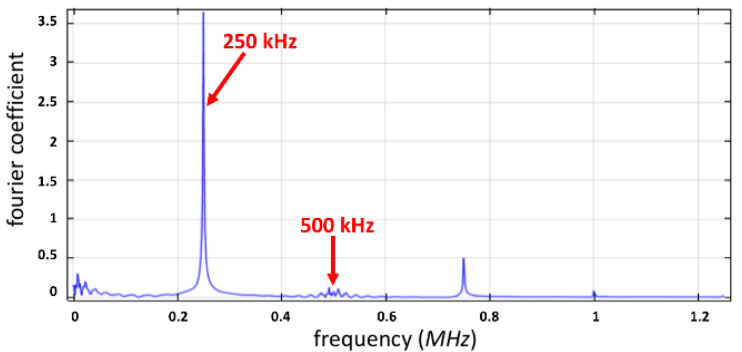
Figure 8. The frequency spectrum at the position (L/2, h) for h cr = 0.38 μ m .